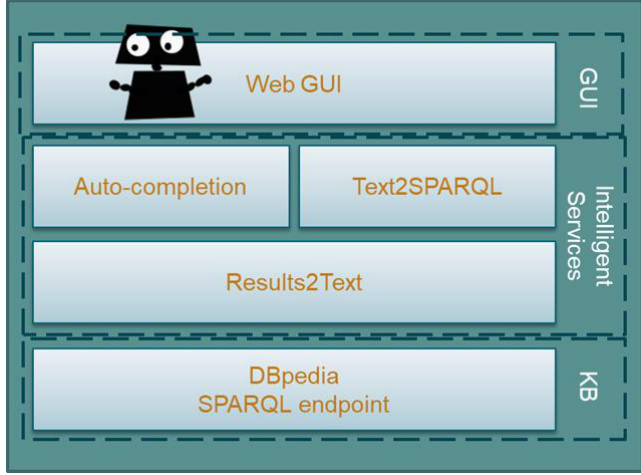
Figure 1. The high-level architecture of the R2D2 chatbot.